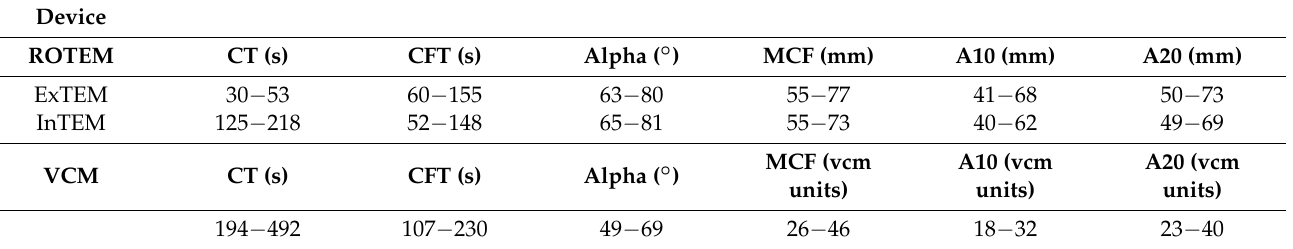
Table 2. Institutional reference intervals for ROTEM and VCM based on results of 20 healthy dogs.